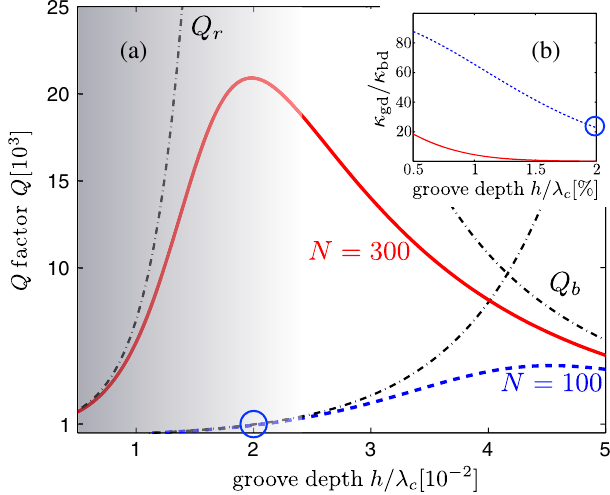
FIG. 2. Characterization of a groove-based SAW cavity. (a) Quality factor Q for N ¼ 100 (dashed blue curve) and N ¼ 300 (red solid curve) grooves as a function of the normal- ized grove depth h= λ . For shallow grooves, Q is limited by c leakage losses due to imperfect acoustic mirrors ( Q regime, gray r area), whereas for deep grooves conversion to bulk modes dominates ( Q regime); compare asymptotics (dash-dotted lines). b = κ (b) Ratio of desired to undesired decay rates κ . The stronger gd bd Q is dominated by Q = κ , the higher κ . Here, w=p ¼ 0 . 5 , r gd bd 3 GHz; typical material parameters for D ¼ 5 . 25 λ , and f c c ¼ LiNbO 3 are used (cf. Appendix